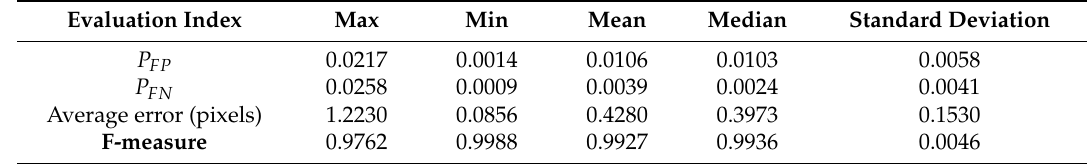
Figure 6. The lake shorelines extracted within the study area. The left-hand side consists of a mosaic formed from six images. The red contours were detected using the proposed method. The right-hand images ( a – c ) show the three selected validation areas with manually digitized boundaries shown as yellow contours. Table 2. Evaluation of the proposed glacial lake detection method for the sampled lakes shown in Figure